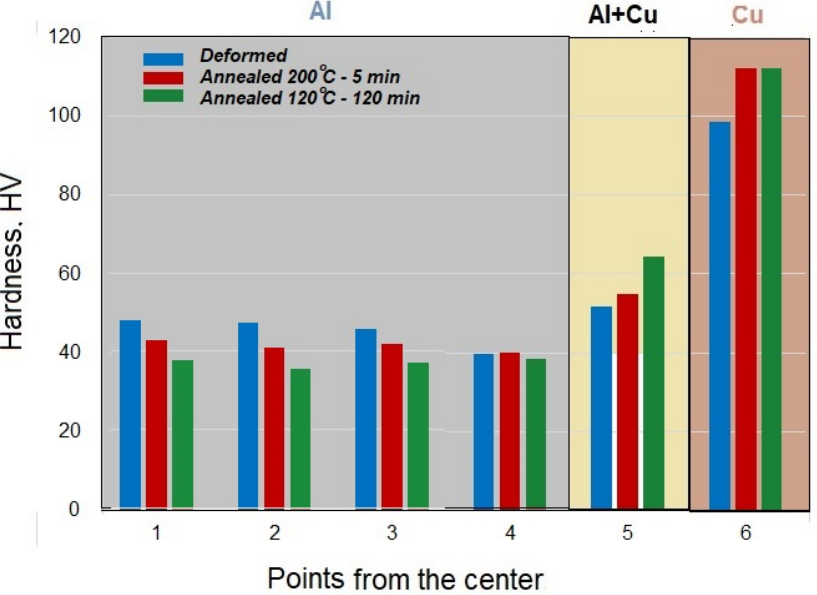
Figure 6. Comparison of hardness after deformation (two passes Route B C ) and annealing measured at six points located in the aluminium part (points 1–4); at the interface (point 5); and in the copper part (point 6) (measured for sample with thick sheath).